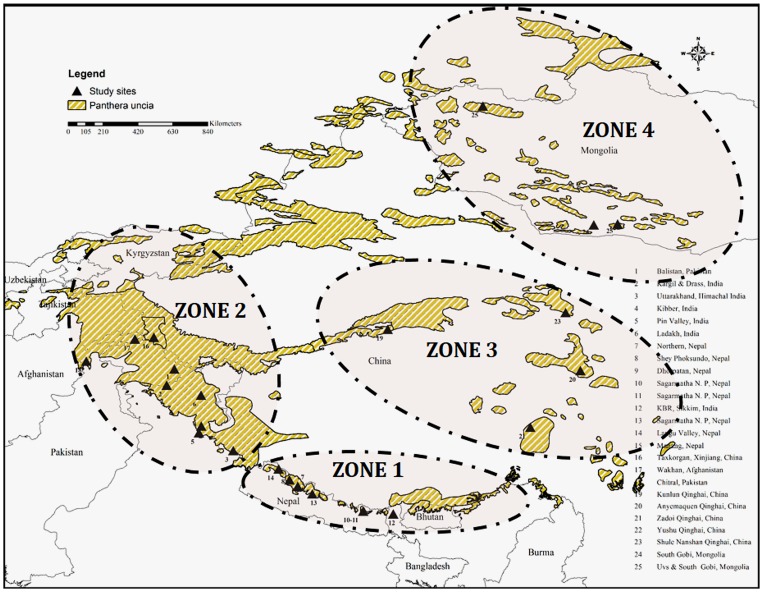
Location of 25 study sites and four physiographic and prey type zones for snow leopard conservation.(Reproduced from IUCN 2012. IUCN Red List of Threatened Species.
Version 2012.1. http://www.iucnredlist.org. Downloaded on 22-02-2013).